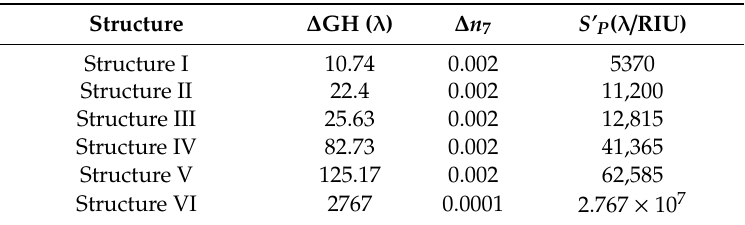
Table 6. The optimal S’ P with ∆ GH and ∆ n 7 for Structure I to Structure VI.